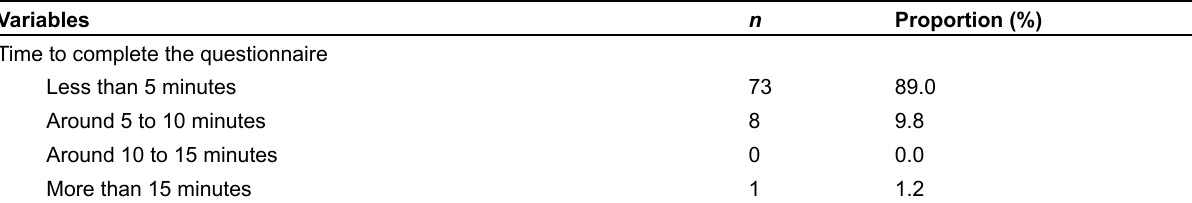
Explor Med. 2021;2:483-93 | https://doi.org/10.37349/emed.2021.00065